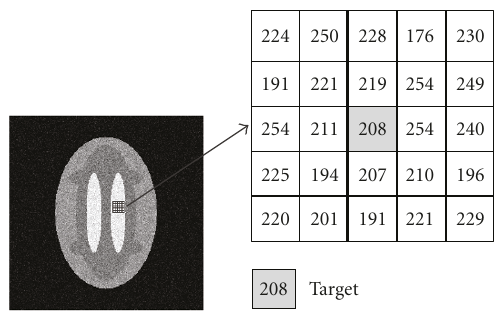
Figure 4: Sketch of antibody population selected.